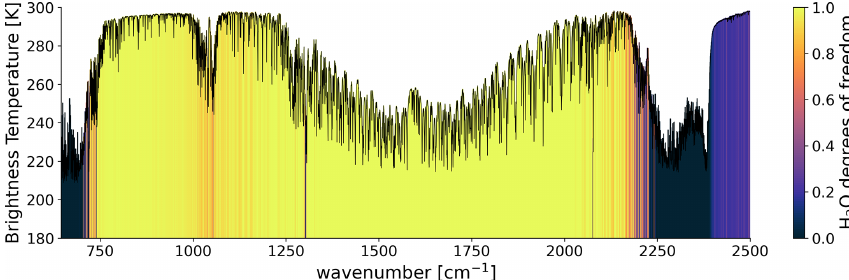
Figure 1. Forward-simulated spectrum in the spectral range of the IASI instrument. Colours denote the water vapour information content of individual channels calculated as the trace of the averaging kernel matrix when only each respective channel is used. Hence, the coloured shading does not account for redundancy of information between channels but simply conveys where water vapour absorption is